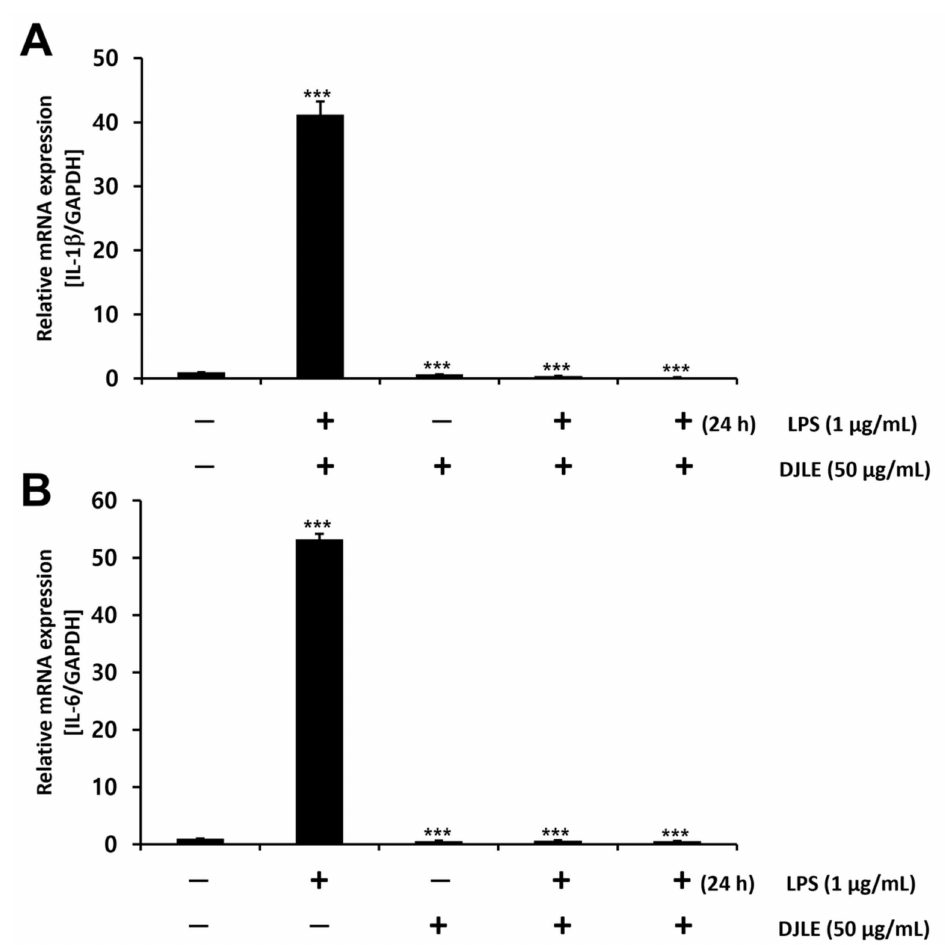
Figure 5. Effect of Daphne jejudoensis leaf extract (DJLE) on the gene expression of the proinflammatory cytokines interleukin-1 β ( A ) and interleukin-6 ( B ) in lipopolysaccharide (LPS)-stimulated human periodontal ligament cells. *** p < 0.001 vs.